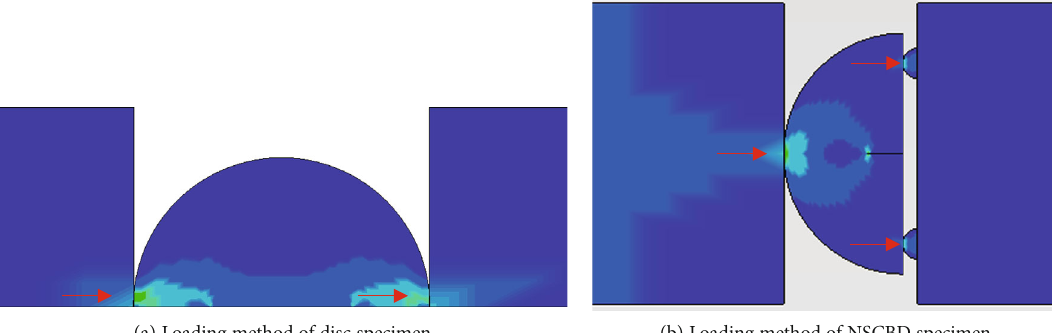
Figure 21: Comparison of loading methods of BD and NSCBD specimens.